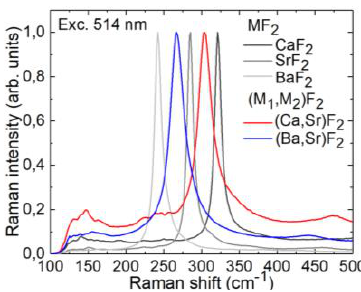
Fig. 2. Unpolarized Raman spectra of the MF 2 and (M 1 ,M 2 )F 2 crystals, λ exc = 514 nm